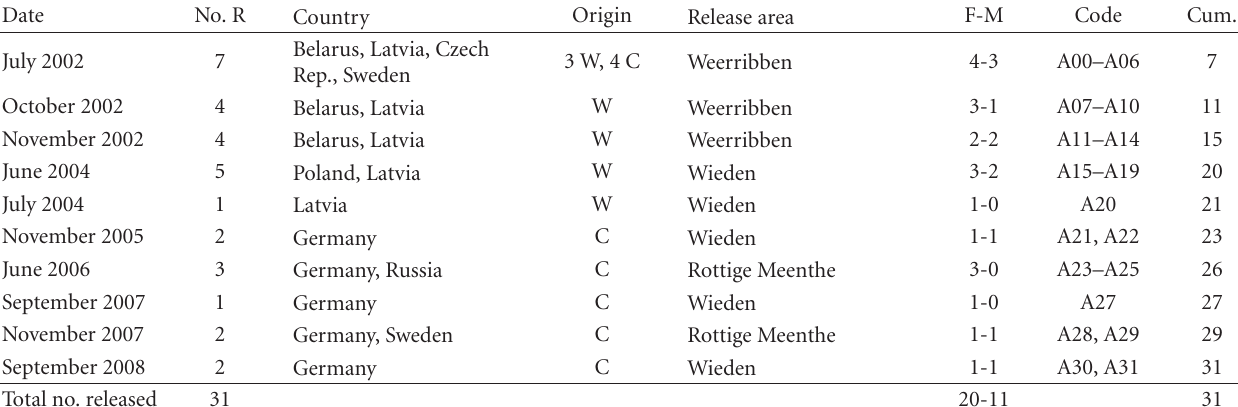
Table 3: Number of otters released until November 2008. Indicated are the date of release, the number released (No. R), countries of origin, origin of the animals (Captive (C) or Wild caught (W)), release area, number of females and males (F-M), the main coding and the cumu- lative number of animals released